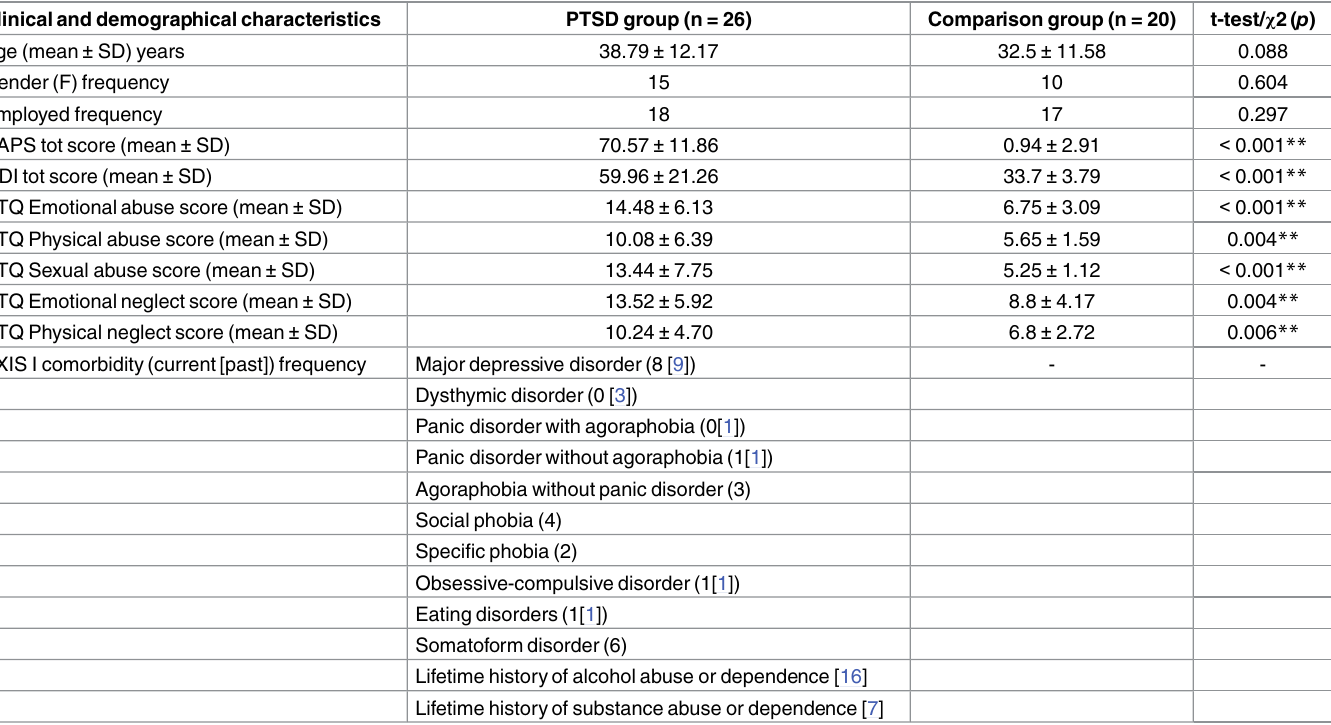
Table 1. Clinicaland demographic informationdividedby